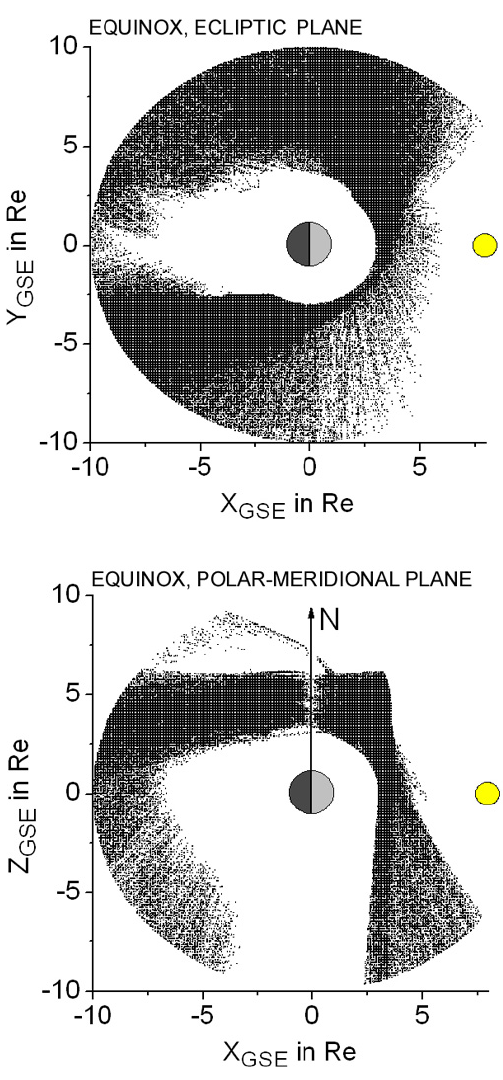
Fig. 4. Observational LOS-coverage: Lines of sight intersections with (top) the ecliptic plane (within an angular extent of θ ± 25 ◦ around the ecliptic plane) and (bottom) the polar–meridonal plane (within an angular extent of φ ± 25 ◦ around the polar–meridional plane) for the equinox